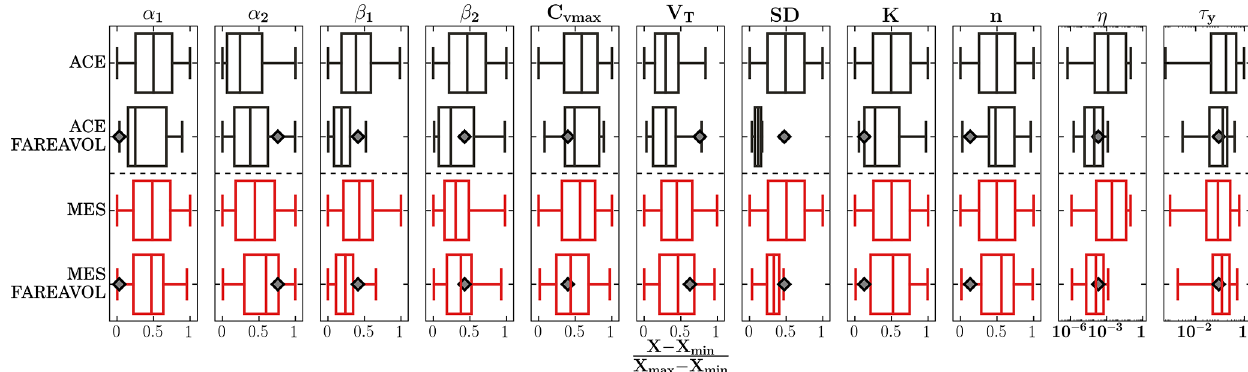
Figure 6. Effects of applying a flood area–volume observational constraint (FAREAVOL) on parameter identifiability. Results are displayed for Acerillas (black) and La Mesilla (red) creeks. The vertical bold line in the boxplots is the median; the body of each boxplot shows the interquartile range ( Q 75 – Q 25 ); and the whiskers represent the sample minima and sample maxima. The grey–black diamonds represent parameter values for the reference